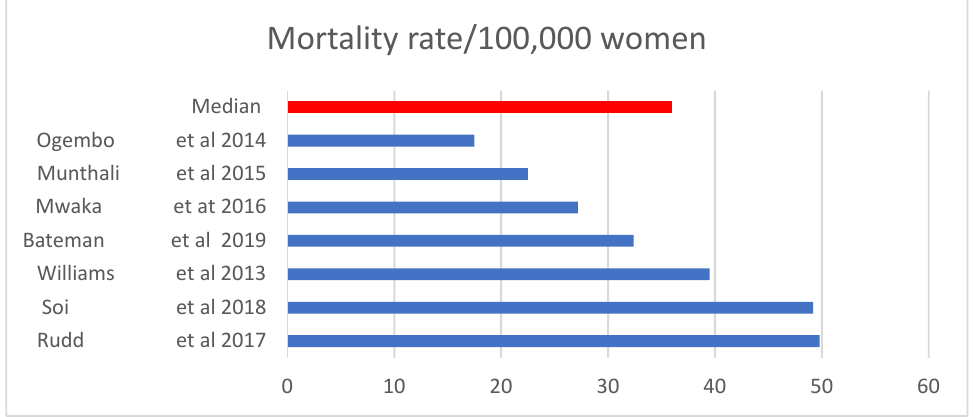
Figure 3. Cervical cancer mortality rate. Sources: [8,11,40,42–45]. Survival rates ranged from 13% to 29% with a median of 17.7% from 7 studies. The statistics are displayed in Figure 4.